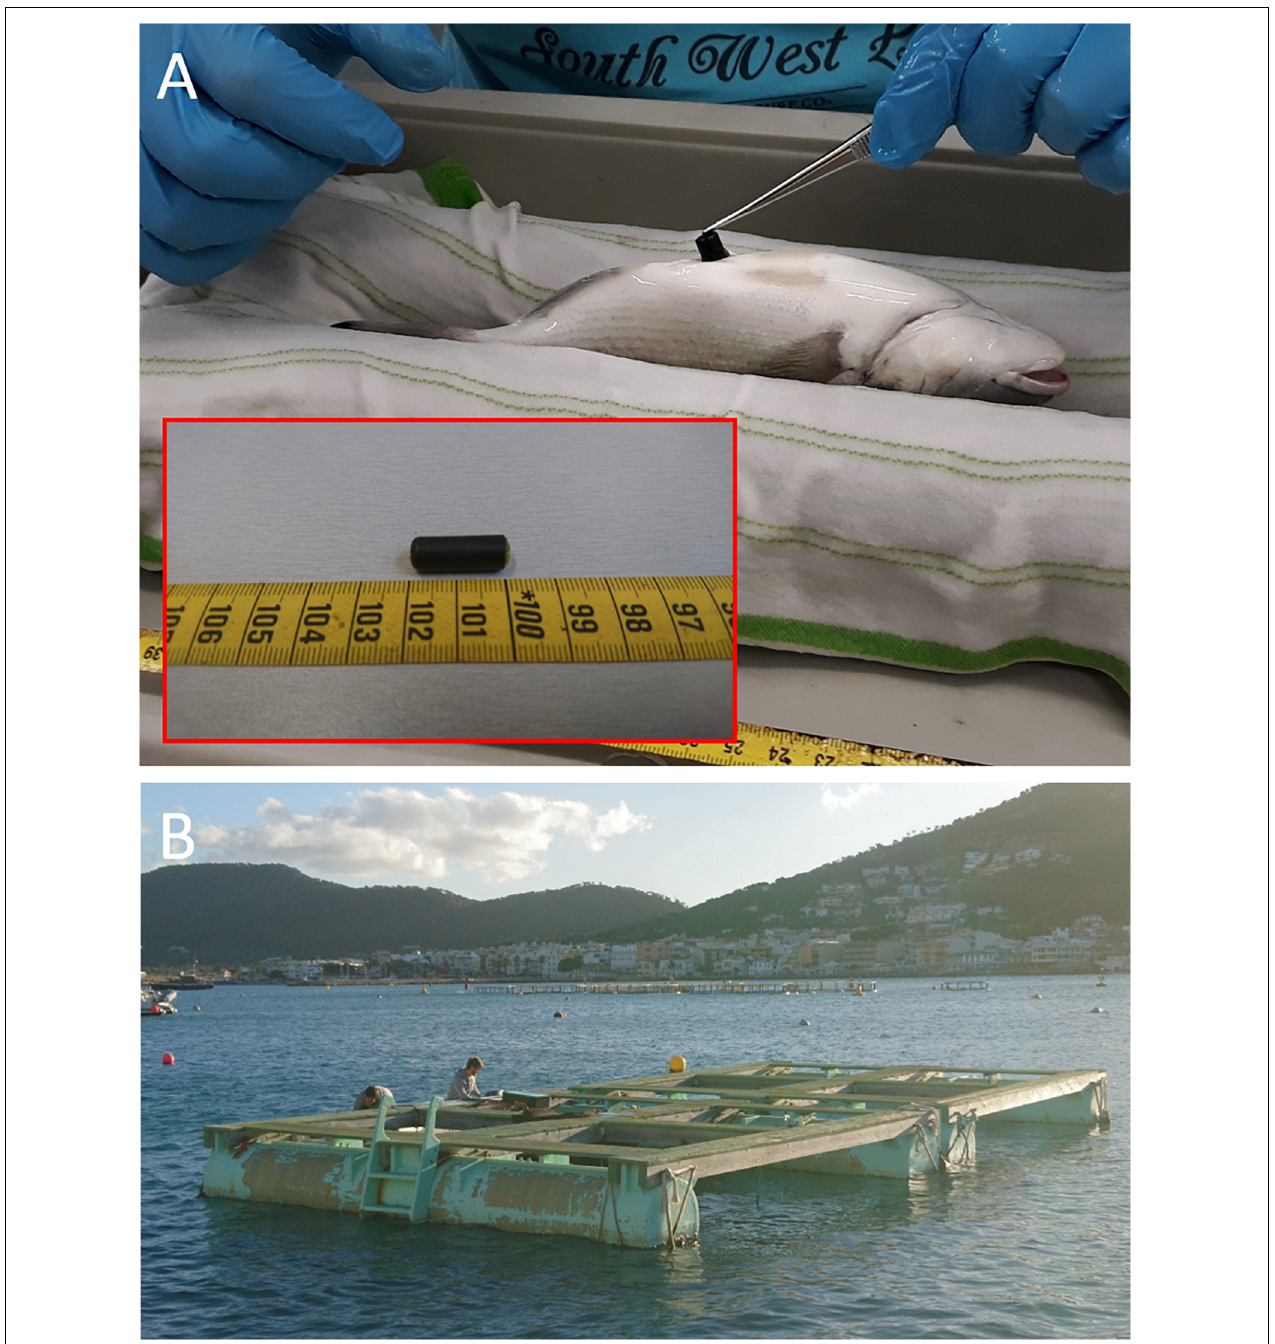
FIGURE 1 | (A) Seabream surgery to implant the tag; insert: tag size, (B) the experimental